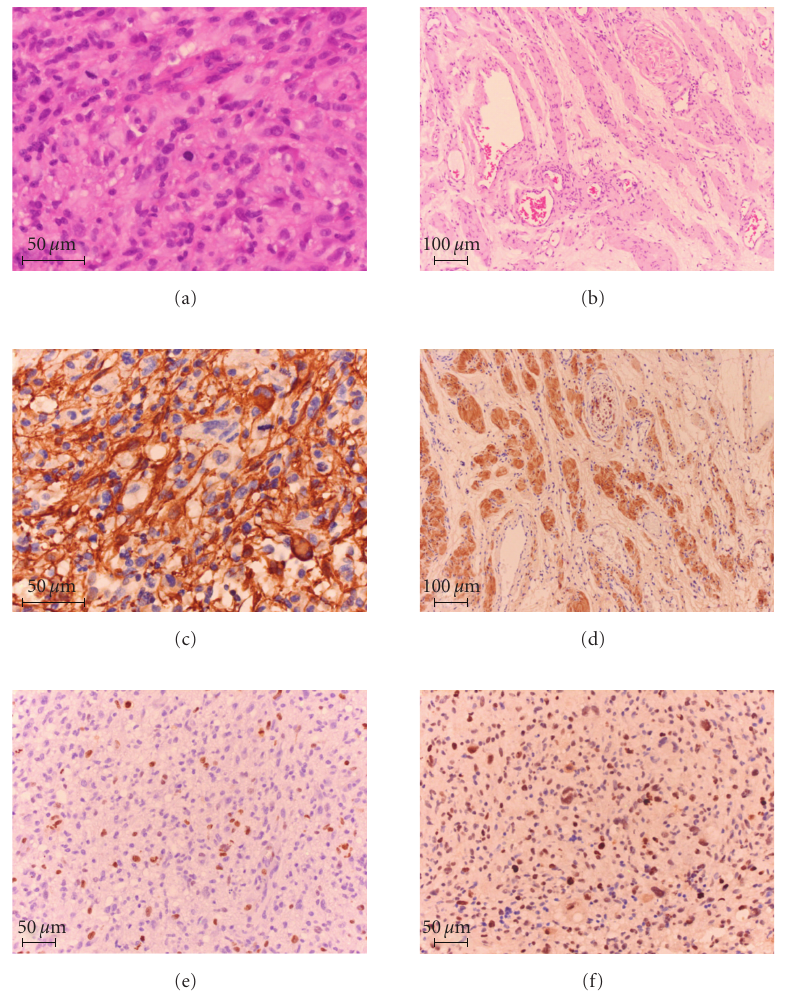
Figure 2: Histopathological and immunohistochemical findings. Histology of the first lesion showed a cellular astrocytic neoplasm (H&E) (a). The second lesion impressed as a neurofibroma (H&E) (b). The first lesion was GFAP positive (c), whereas the second was not (data not shown). This lesion was however positive for S100 (d). ∼ 10%–15% of the nuclei of the first lesion were immunohistochemically stained for Ki-67 (MiB1) (e). In this lesion, approximately 30% of the cells showed immonupositivity for p53